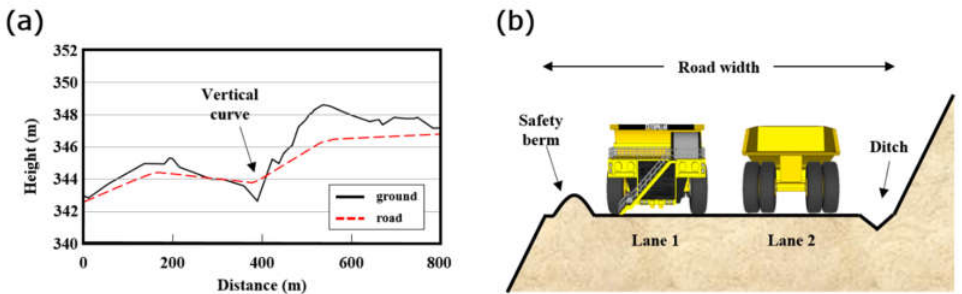
Figure 9. Conceptual view of factors to be considered when generating a 3D haul road. ( a ) Cross section of a haul road showing the height (solid line) of the ground and the vertical layout (dashed line). ( b ) Road geometry showing a cross section of the road